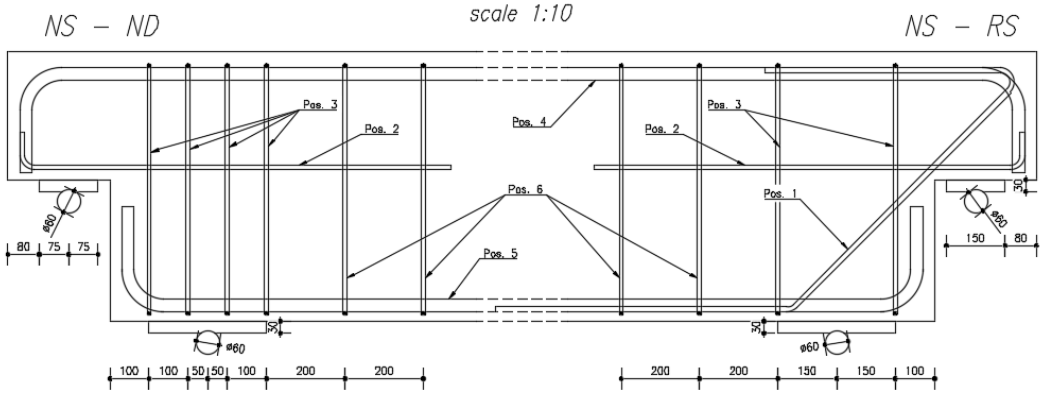
Figure 4. Reinforcement description and geometry—NS-ND and NS-RS.